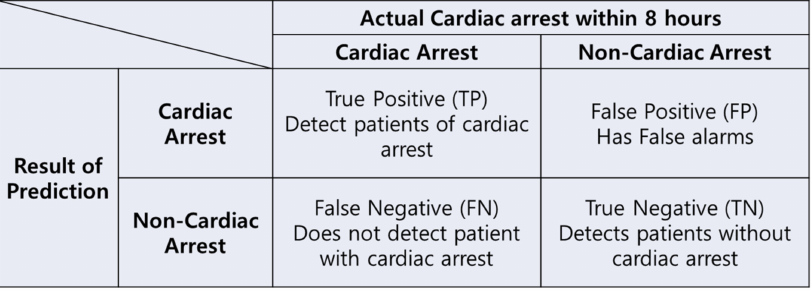
Figure 2. Four types of data